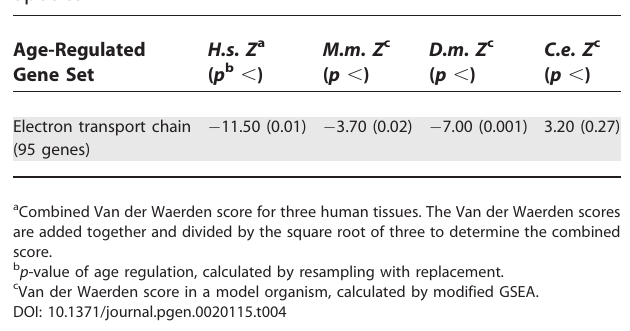
Table 4. Age Regulation of the Electron Transport Chain in Three